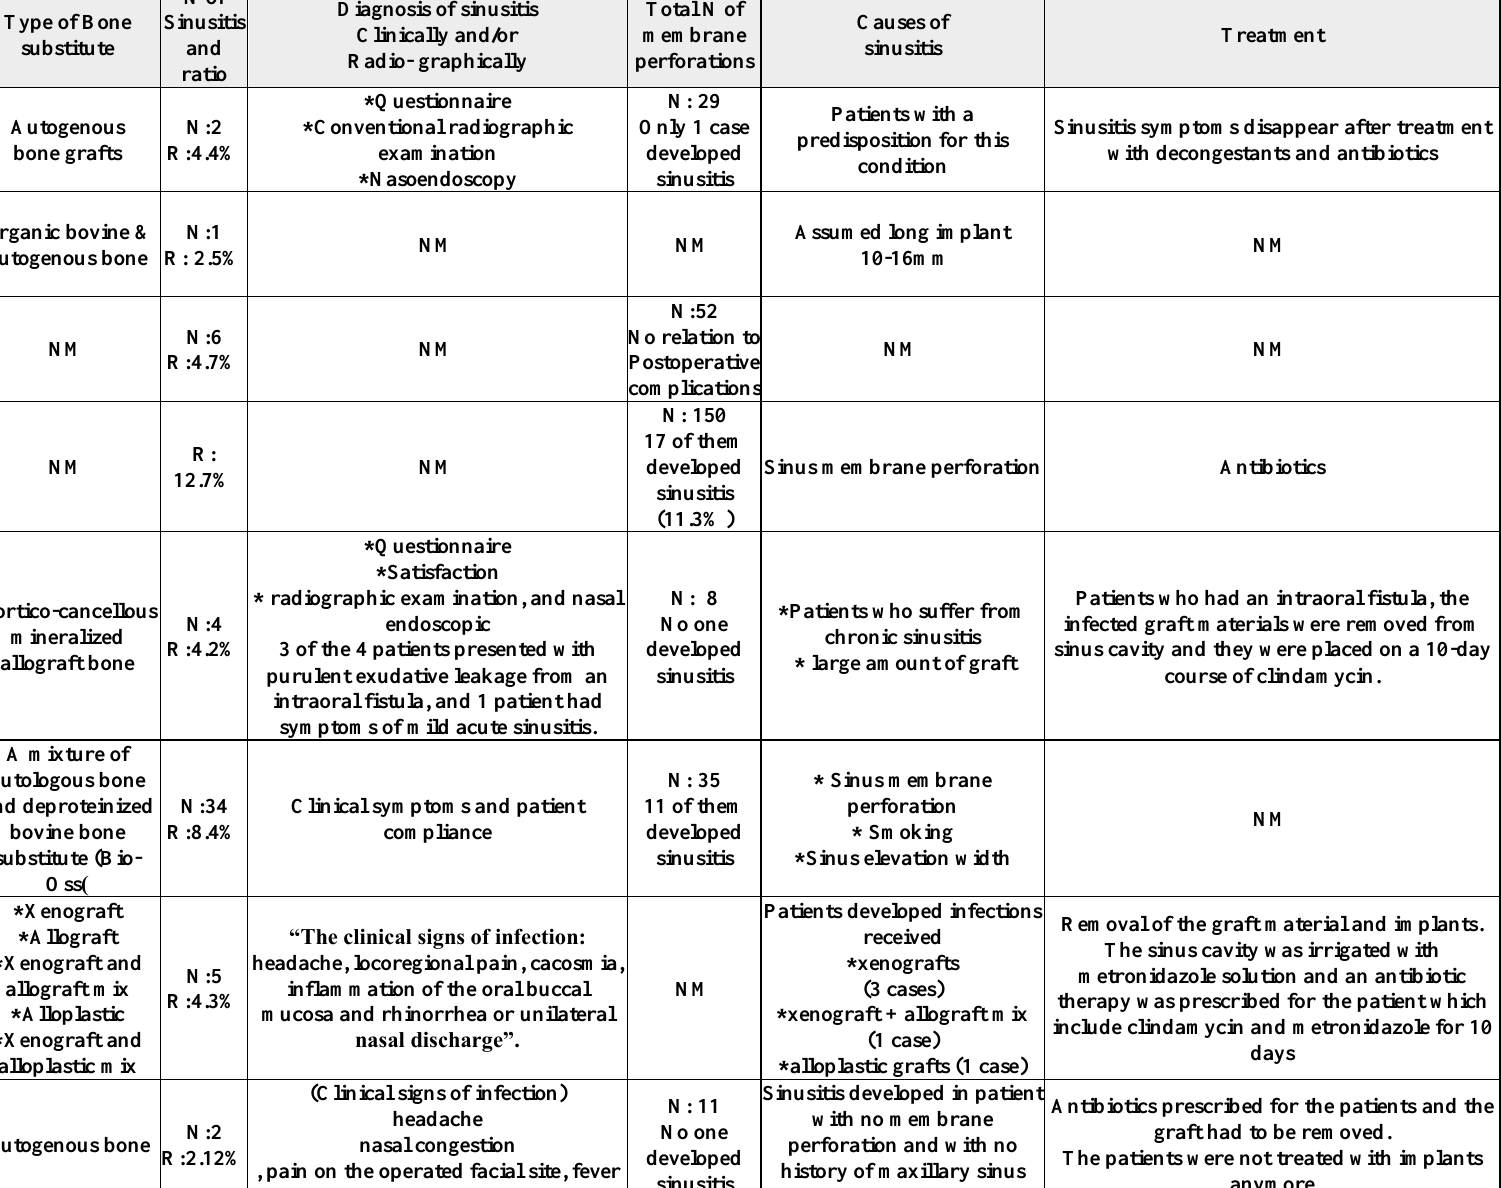
Total N of Causes of Treatment sinusitis